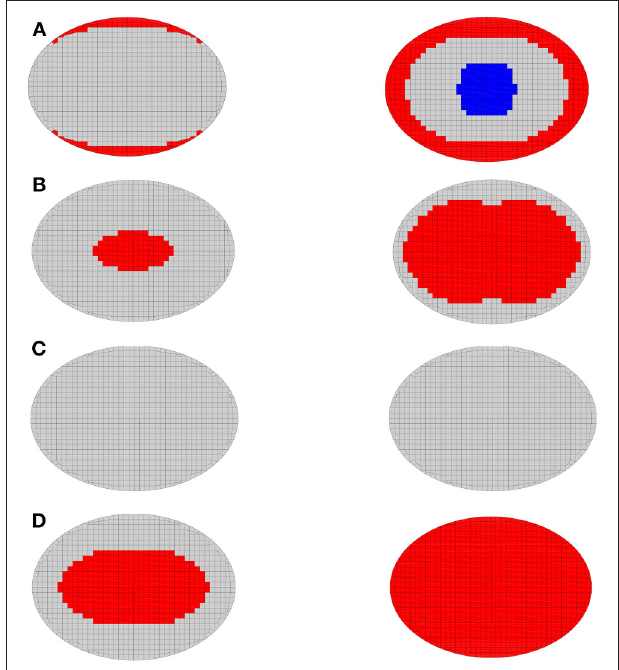
FIGURE 14 | Cracking propagation of an elliptic slab on the: (A) top-clamped, (B) bottom-clamped, (C) top-simple supported, and (D) bottom-simple